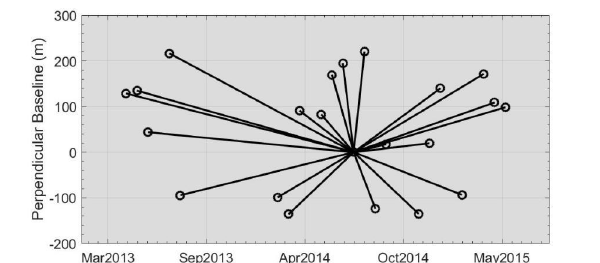
Figure 2. Baseline distribution of data